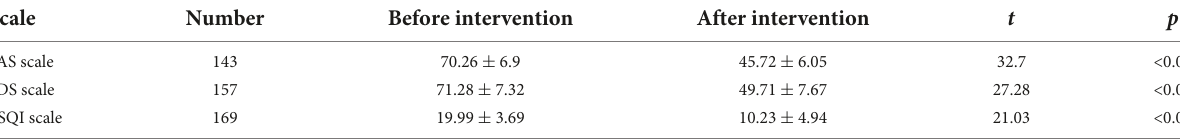
TABLE 2 Comparison of anxiety, depression and sleep disorders before and after